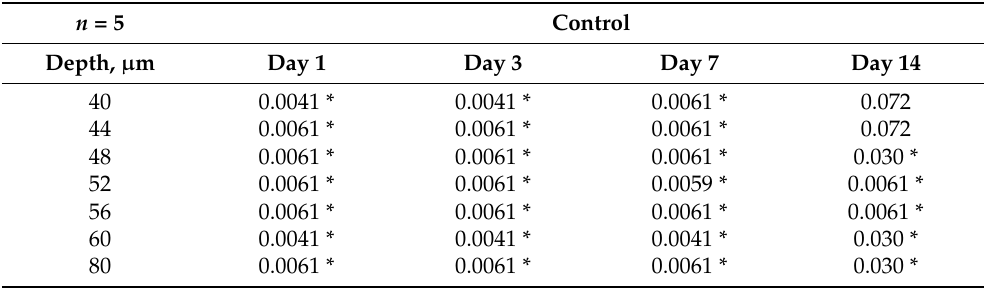
Table 2. The p -value for the SAAID of the control group relative to healthy skin.